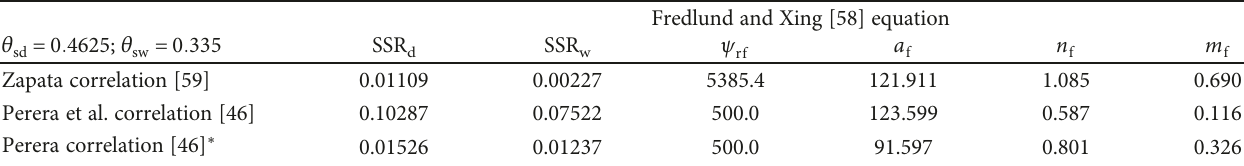
Figure 11: Performance of the two prediction models compared with the Fredlund and Xing [58] equation obtained by using the nonlinear regression procedure on the measured data. Table 4: Fredlund and Xing [58] equation parameters and SSR values obtained using the Zapata [59] and Perera et al. [46] correlation models for the